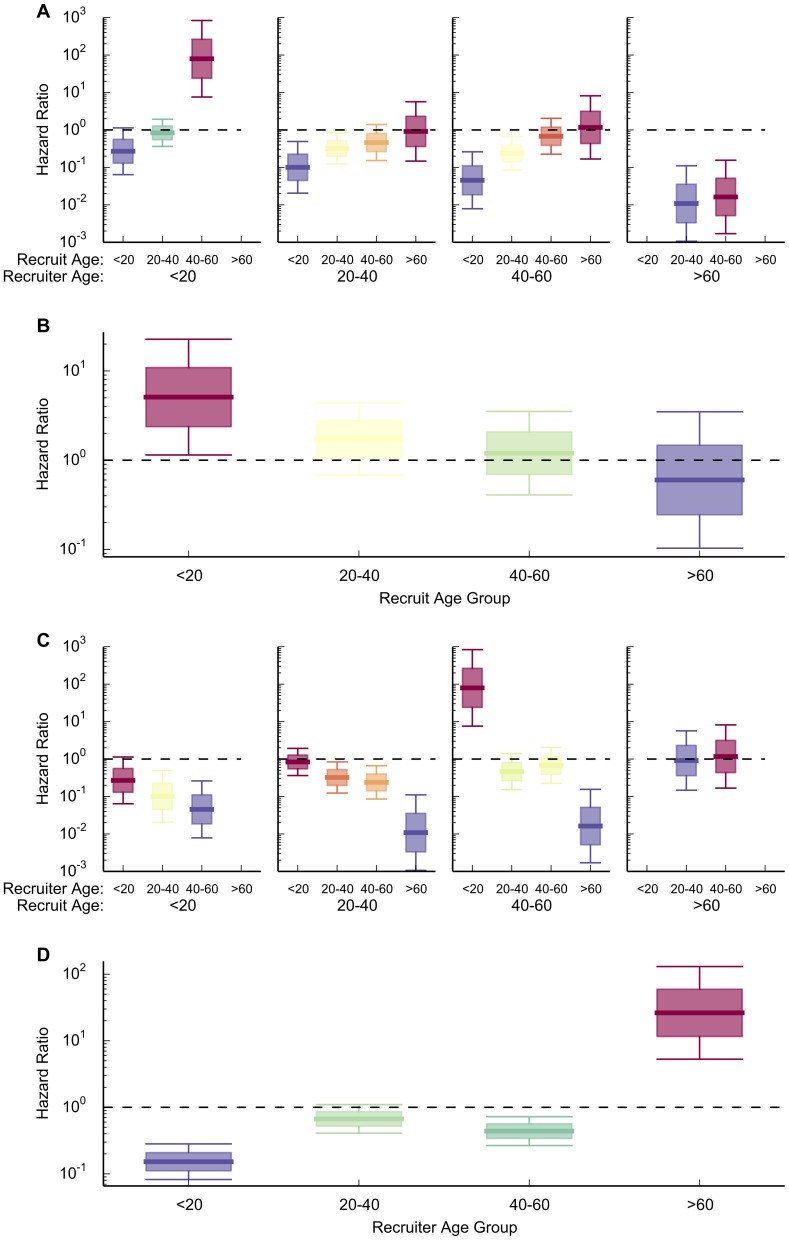
Older recruits and younger recruiters had faster mobilization speeds, as revealed by the interaction of recruiter and recruit age.In the Yule-Simpson paradox the interaction effect of two factors contrasts with the main effect of either factor taken individually, as is the case with recruit and recruiter ages' relationship with mobilization speed. In such a case the interaction effect supersedes the main effect. Absent plots indicate no data for that interaction. (A) The interaction of recruiter and recruit age group on mobilization time, grouped by the recruiter's age. For any given recruiter age group, mobilization speed increased with the recruit's age. (B) The main effect of the recruit's age group on mobilization speed, which had the opposite behavior of that found in the interaction effect seen in (A). (C) The interaction of recruiter and recruit age group on mobilization time, grouped by the recruit age. For any given recruit age group, mobilization speed decreased with the recruiter's age. This is a simple rearrangement of the information in (A). (D) The main effect of the recruiter's age group on mobilization speed, which has the opposite behavior of that found in the interaction effect seen in (B).